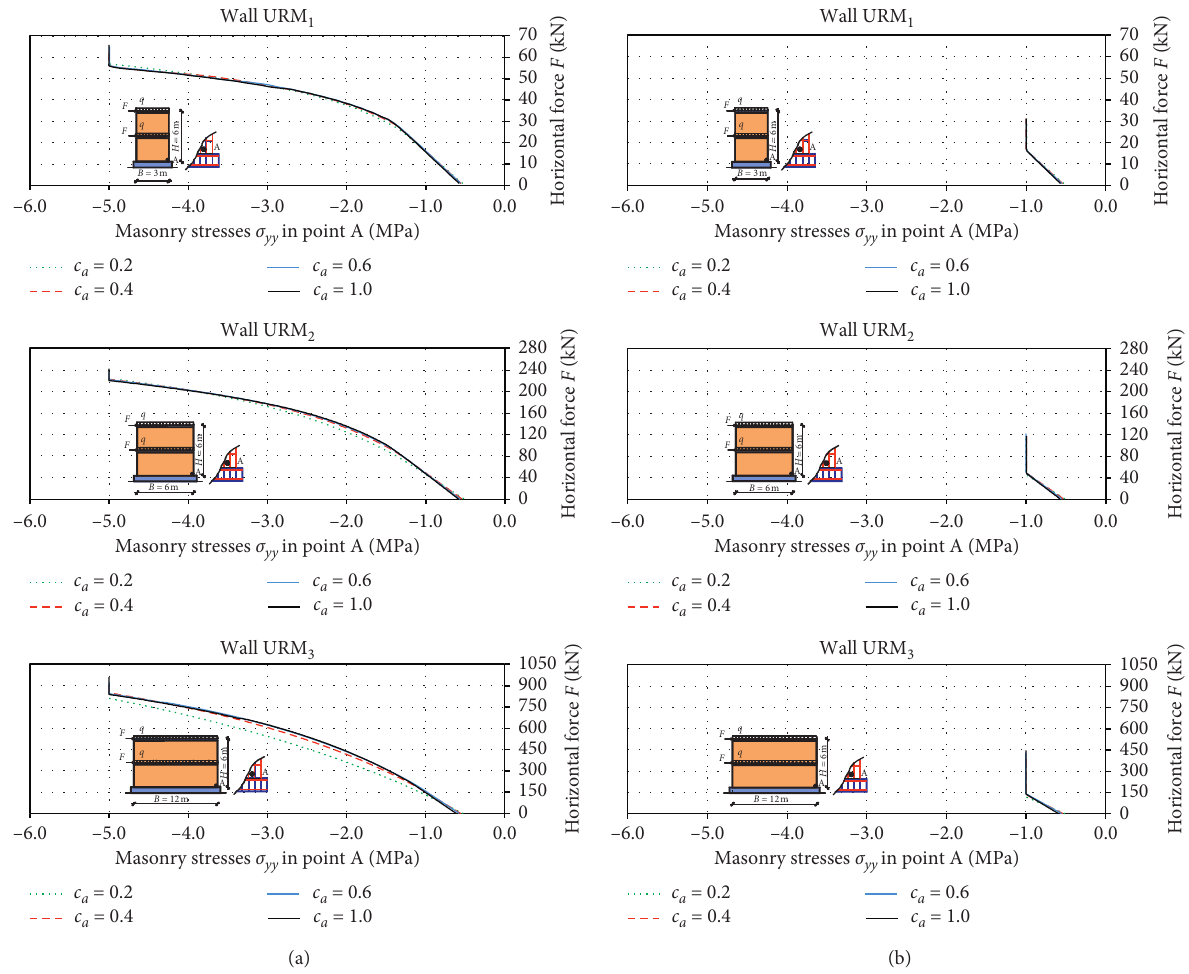
Figure 12: Vertical stresses in masonry in point A at the bottom of unreinforced masonry walls: (a) stiff masonry; (b) soft